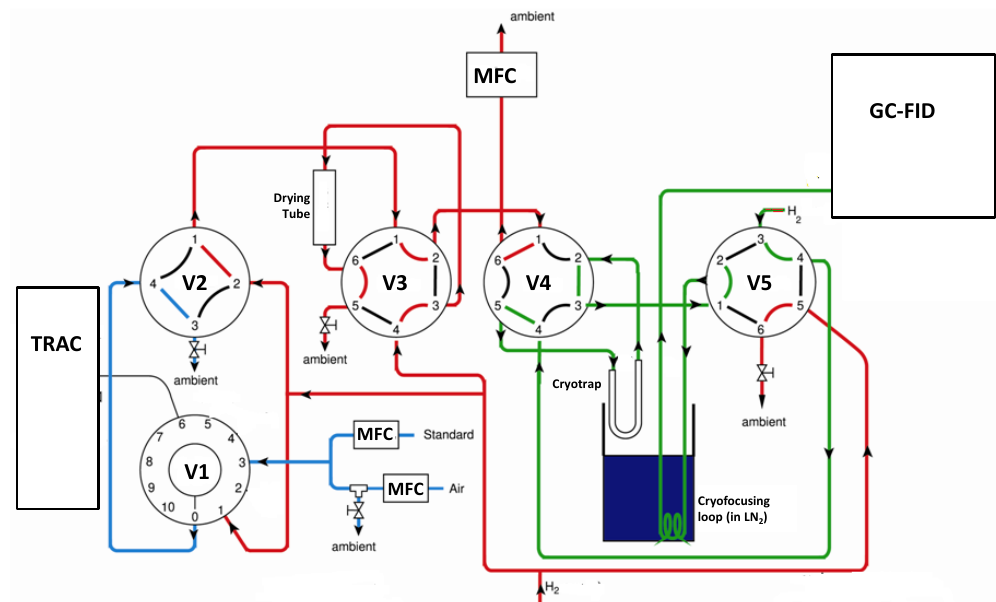
Fig. 1. Schematic of the pre-concentration and GC-FID system for measurement of NMHCs (see text). Lines shown in blue, green and red represent the flow of the analyte being introduced (in this case a standard), the hydrogen carrier and analyte to be delivered to the GC, and hydrogen for pre-concentration and drying agent regeneration, respectively. Bent and straight valve connections represent the two possible valve configurations used during